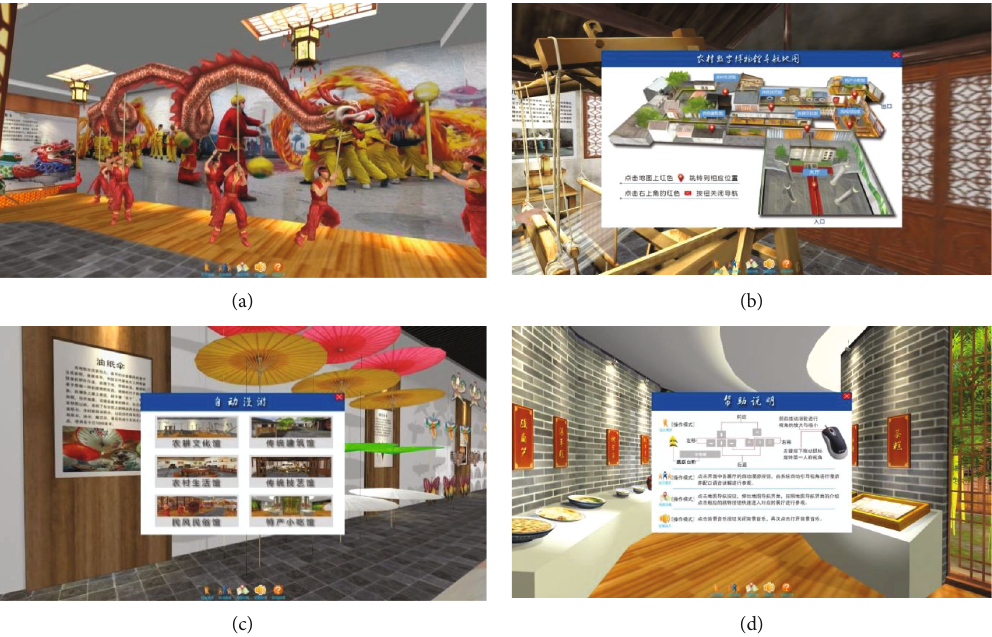
Figure 3: (a) Free roaming of the Mt. Mogan rural virtual museum. (b) Map roaming of the Mt. Mogan rural virtual museum. (c) Automatic roaming the Mt. Mogan rural virtual museum. (d) Operating instructions of the Mt. Mogan rural virtual